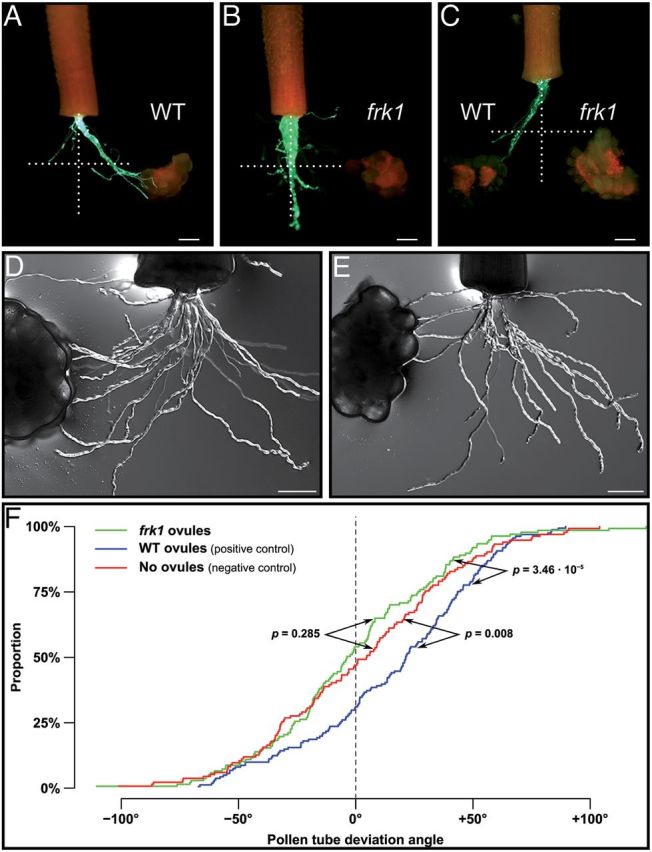
Pollen tube guidance is affected in ScFRK1 transgenic plants. (A) Single-choice pollen tube guidance assay with WT S. chacoense ovules. Pollen tubes express the GFP marker under the control of the tomato Lat52 promoter (A–C). (B) Single-choice pollen tube guidance assay with Scfrk1-S1 ovules. (C) Two-choice pollen tube guidance assay with WT and Scfrk1-S1 ovules. (D, E) Single-choice pollen tube guidance assay with limited pollen load in order to measure pollen tube angles from WT (D) and Scfrk1-S1 ovules (E). (F) Kolmogorov–Smirnov statistical analysis from the angle distribution in D and E. Scale bar=200 μm.